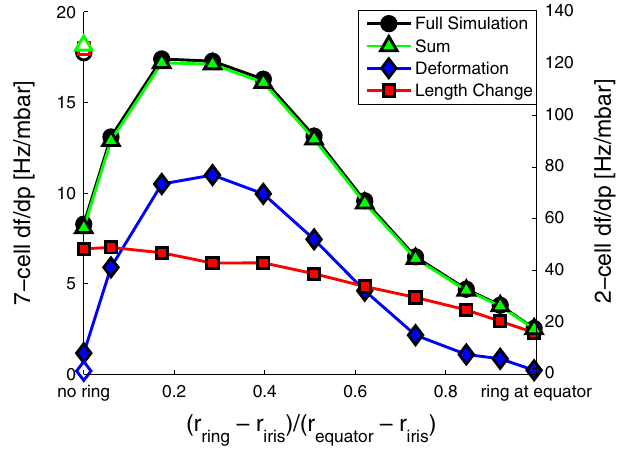
FIG. 12. Comparison of the breakdown of df=dp to the full simulation. The open markers correspond to the 2-cell